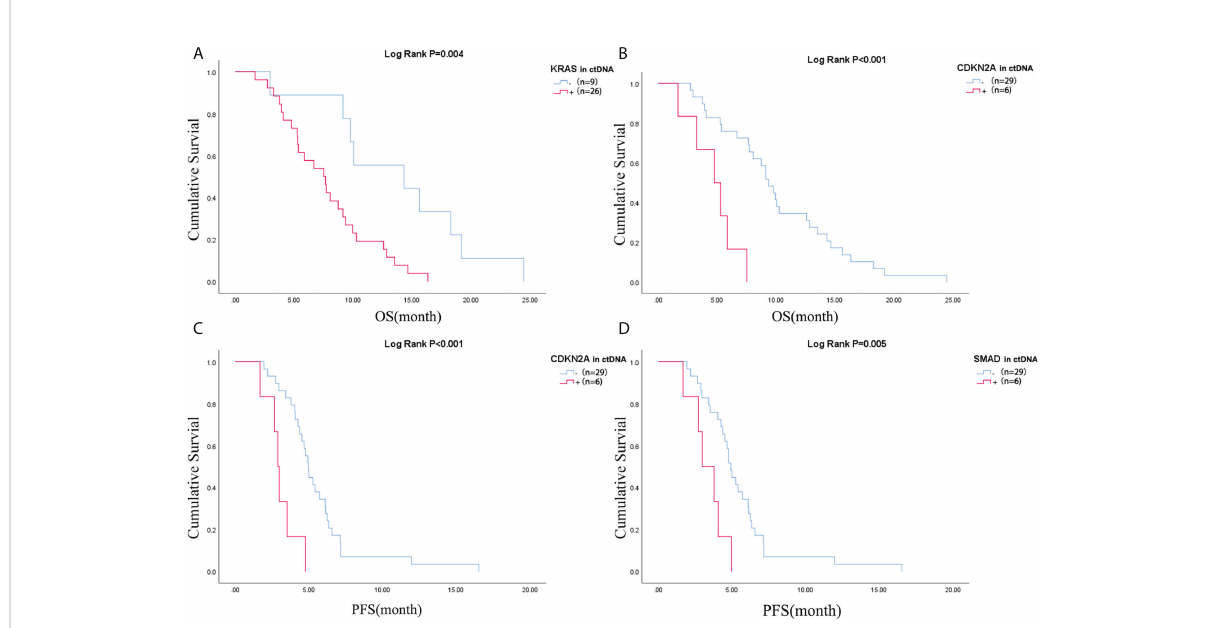
FIGURE 4 Difference of OS of patients in (A) KRAS mutation negative and positive in ctDNA group and (B) CDKN2A mutation negative and positive in ctDNA group; Difference of PFS of patients in (C) CDKN2A mutation negative and positive in ctDNA group and (D) SMAD4 mutation negative and positive in ctDNA group. OS, overall survival; PFS, progression-free survival; ctDNA, circulating tumor DNA.